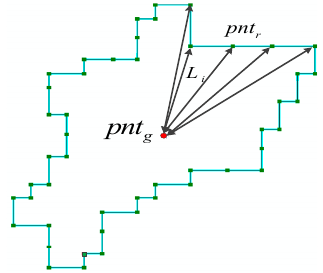
Figure 4. Shape described by length between gravity point and boundary points.